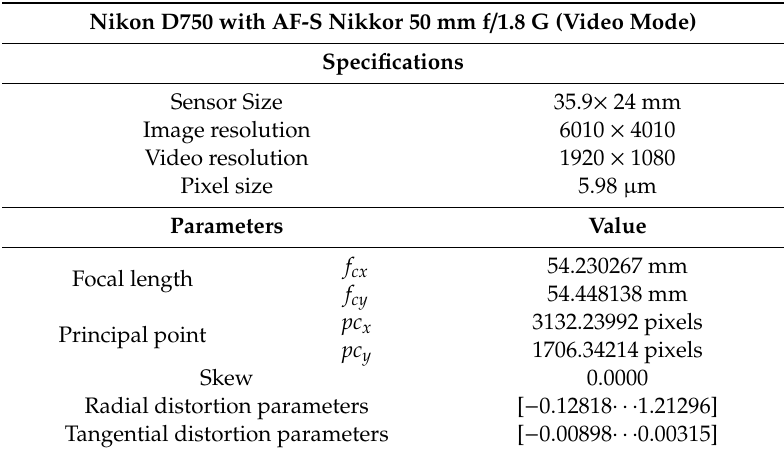
Table 1. Specifications and calibration results of the camera.